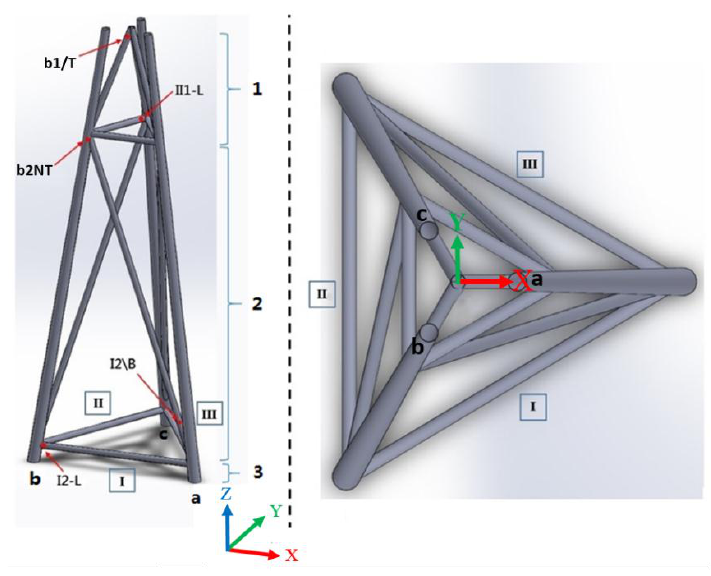
Figure A13. Four levels of abbreviations and examples used for MJ-structure members and parts.